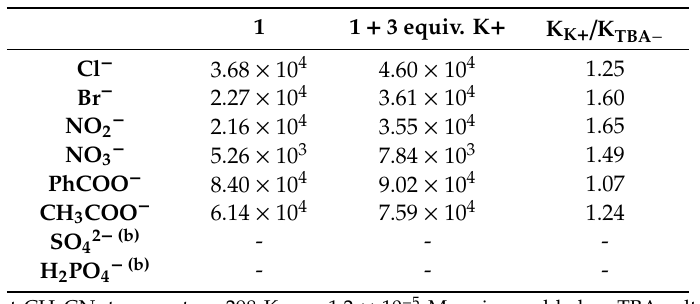
data fitted to 1:1 binding model. Errors < 10%, see Supplementary Materials. Stability constants for receptor 1 : K = 3.94 × 10 4 M − 1 forCl − inthepresenceof3equivalentsofNa + . Stabilityconstantsforreceptor 2 (c = 1.4 × 10 − 5 M): K = 4.09 × 10 4 M − 1 for Cl − . K = 3.58 × 10 4 M − 1 for Cl − in the presence of 3 equivalents of K + . Stability constants